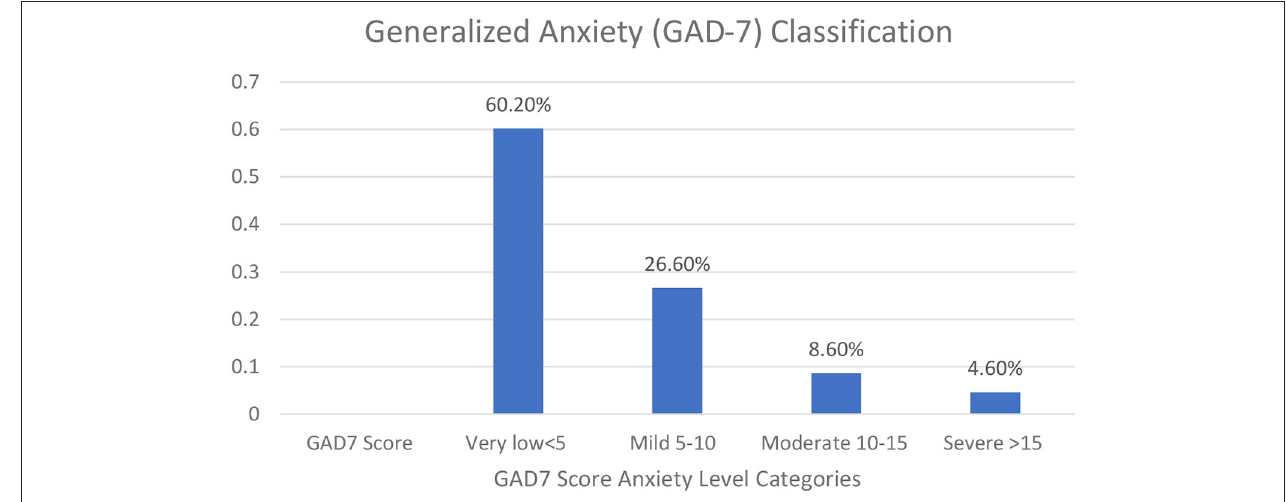
FIGURE 2 | HCWs’ generalized anxiety disorder assessment (GAD-7)